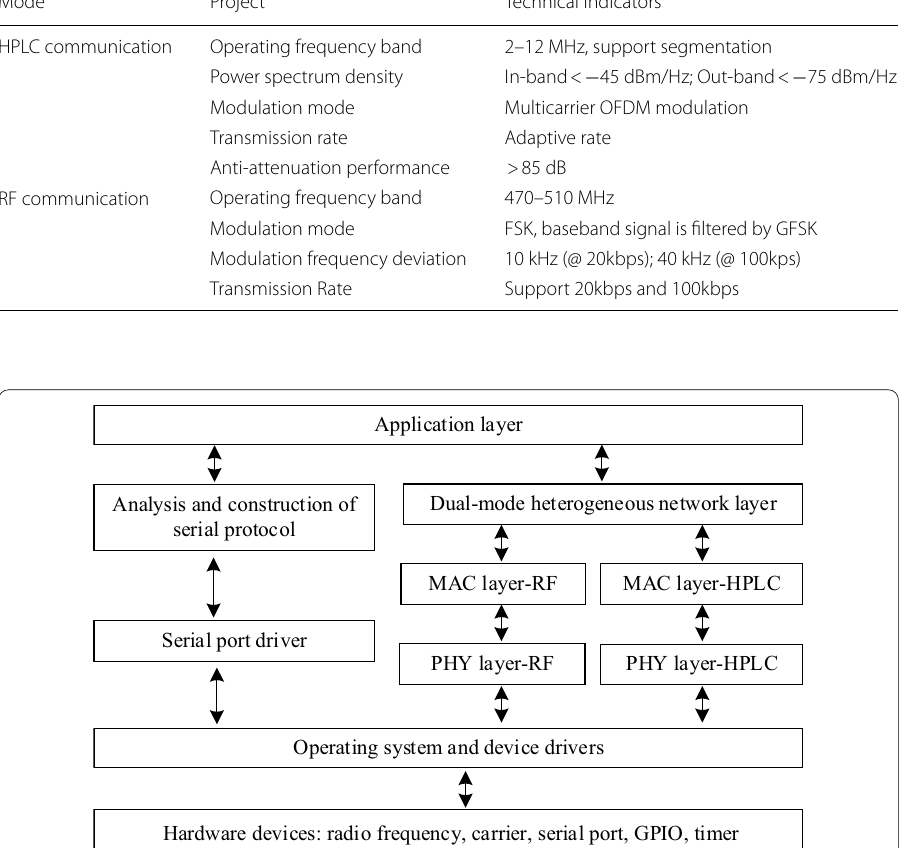
Table 1 Primary communication parameters of dual-mode communication module Mode